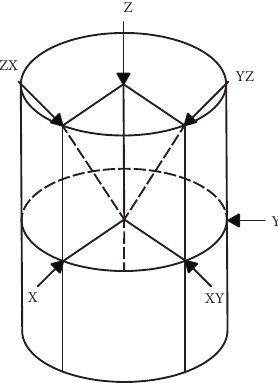
Figure 2: Corresponding axial positions of the strain